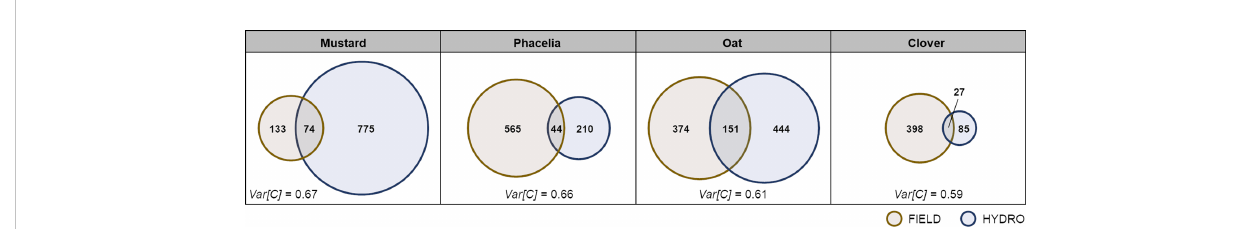
FIGURE 2 Feature presence of secondary metabolites in root exudates of cover crops grown in the fi eld or hydroponically. Venn diagrams show numbers of unique semi-polar features detected by an untargeted LC-MS/MS approach in root exudates of mustard, phacelia, oat and clover sampled in the fi eld (FIELD) or hydroponically (HYDRO) and features being present in both cultivation systems within the overlapping part; n=9-11 [FIELD], n=3-4 [HYDRO]. “ Var[C] ” indicates the variation explained by the cultivation conditions (FIELD vs. HYDRO) calculated on a presence/absence matrix for secondary metabolites in individual samples by constrained correspondence